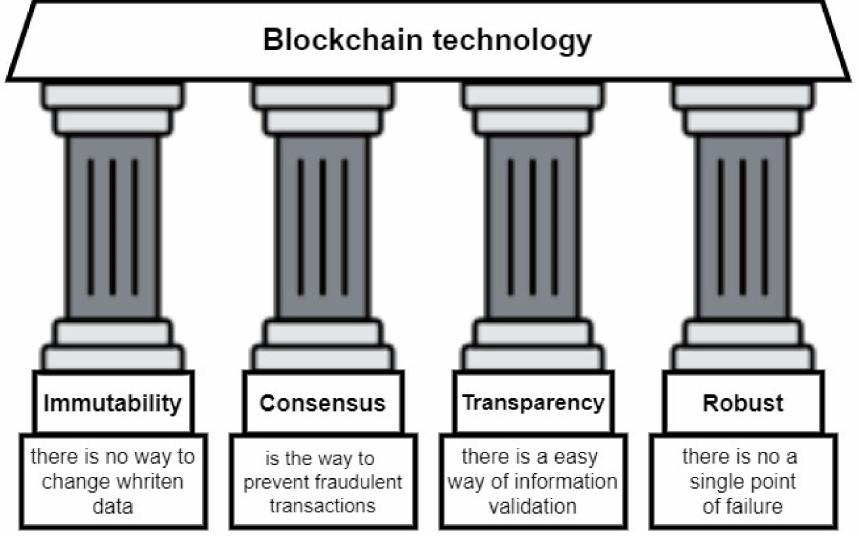
Figure 4. The pillars of blockchain